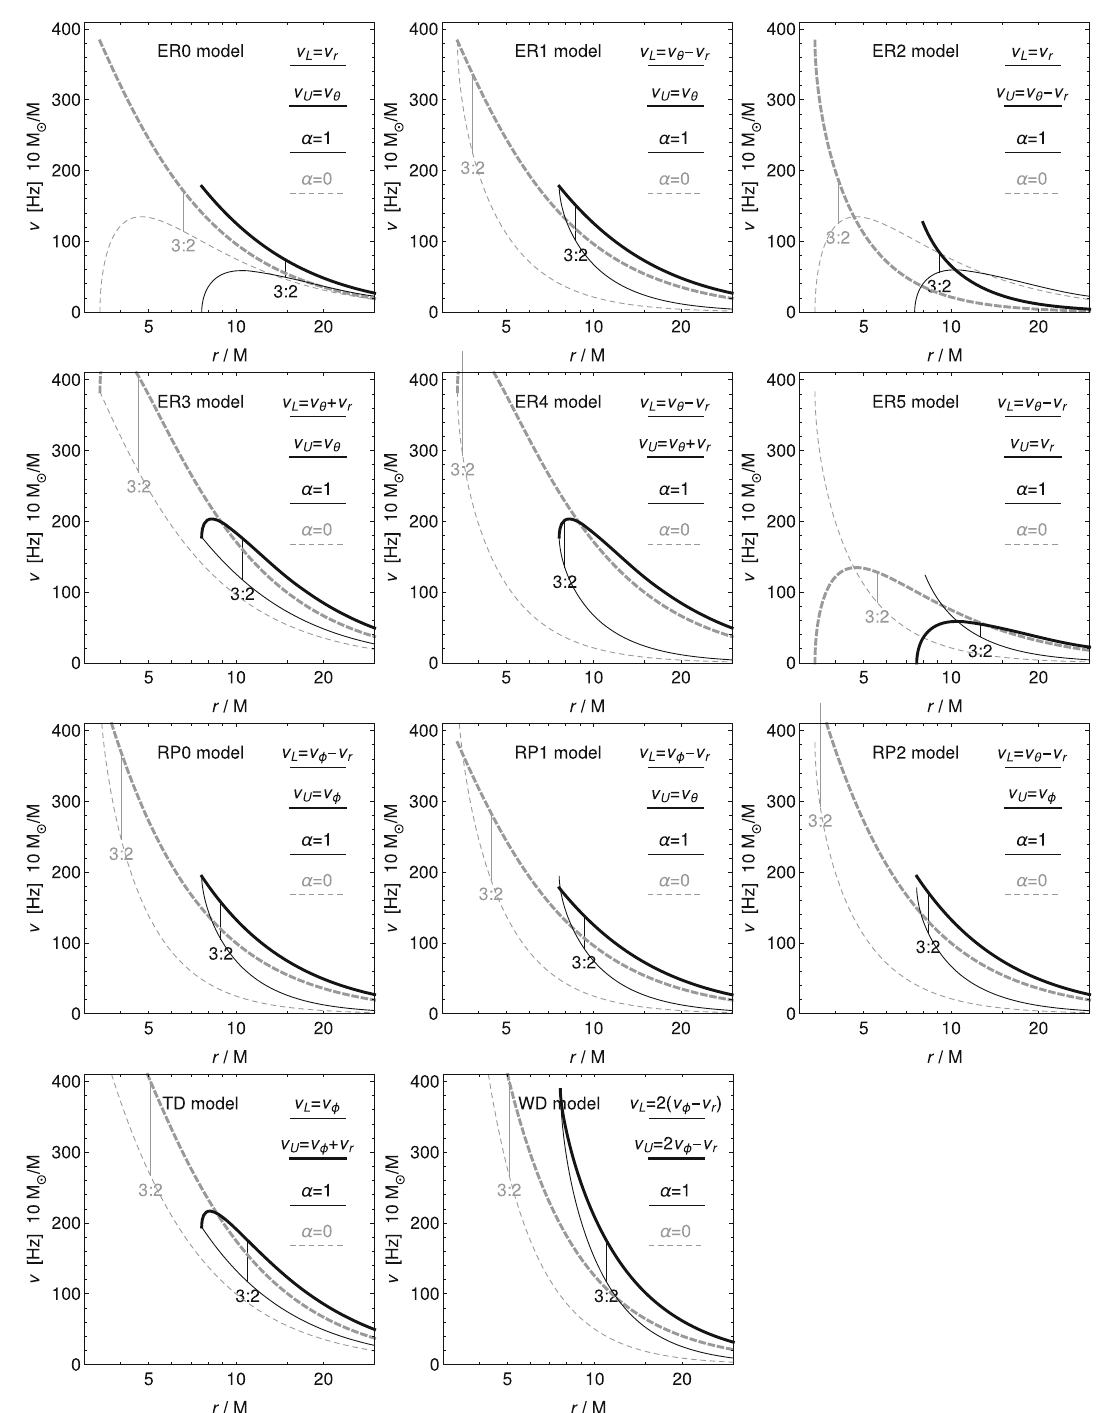
Fig. 4 Radial profiles of lower ν L ( r ) and upper ν U ( r ) frequencies for various HF QPOs models, see Sect. 5.2. The frequencies are plotted for classical Kerr BH ( α = 0) as gray curves, while as black curves for ture [18]. The warped disc WD oscillation model of twin HF QPOs assumes non-axisymmetric oscillatory modes of a thin disc [15], for the WD model with frequencies presented